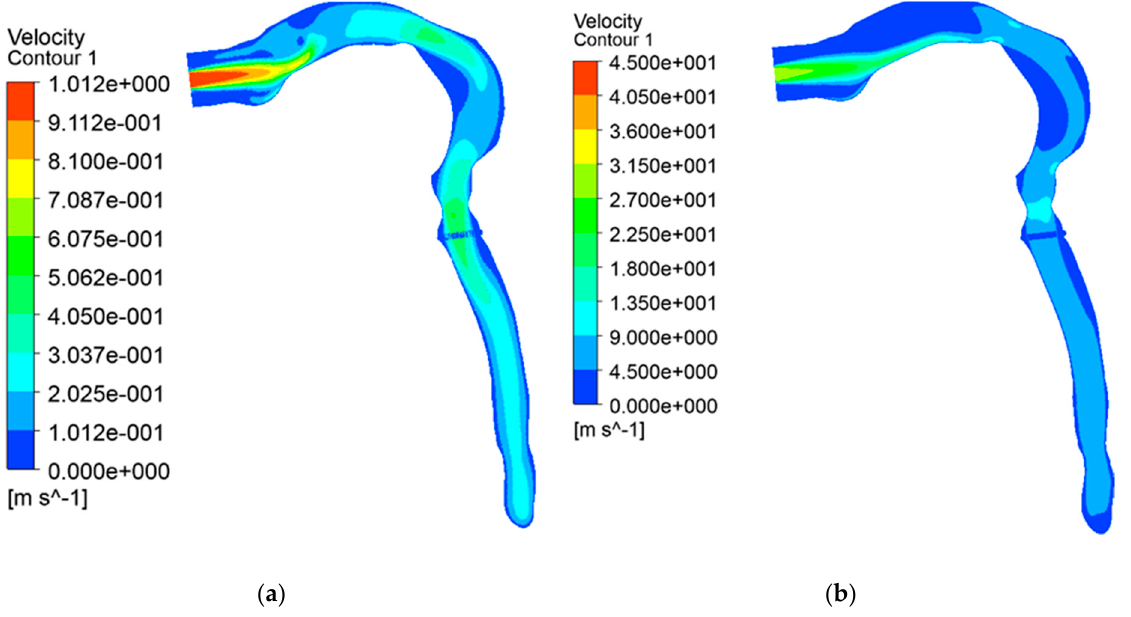
Figure 10. Velocity contour. ( a ) Transient puffing. ( b ) Transient post-puffing inhalation.